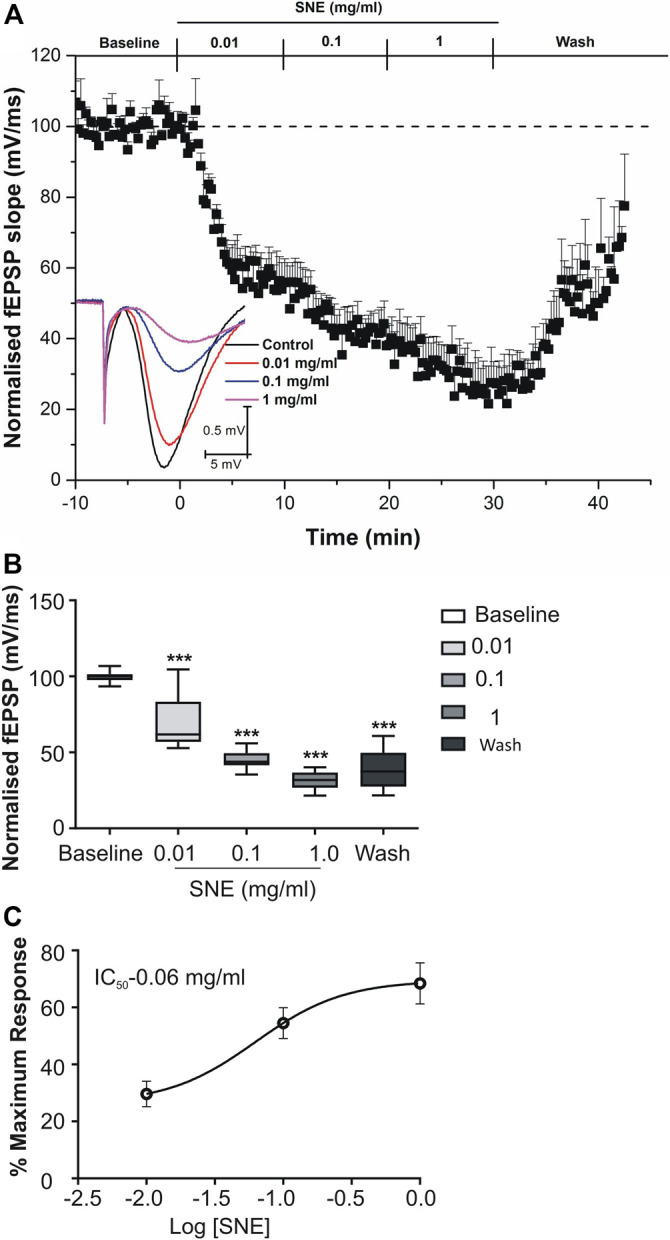

(A) Effect of SNE (0.01, 0.1 and 1.0 mg/ml) on slope of fEPSPs in rat hippocampal slices after a stable baseline perfused with normal aCSF. (B) The bar graph represents the total effect (calculated as AUCs from the graph above). (C) Concentration-response curve from SNE (0.01, 0.1, and 1.0 mg/ml) on slope of fEPSPs. Data is mean ± SEM (n = 5). ***p < 0.001 compared with baseline, one-way ANOVA followed by a Dunnett’s multiple comparison test.